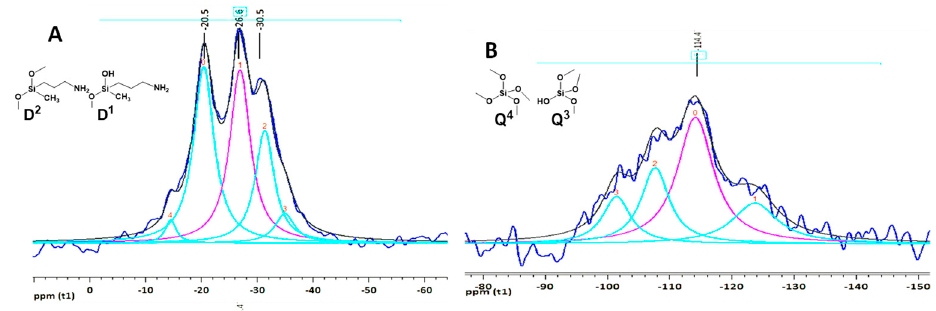
Figure 8. 29 Si solid-state CP-MAS NRM spectra of HMMSN hybrid magnetic mesoporous nanorods with fittings of (A) D n siloxane centers and (B) Q n siloxane centers.